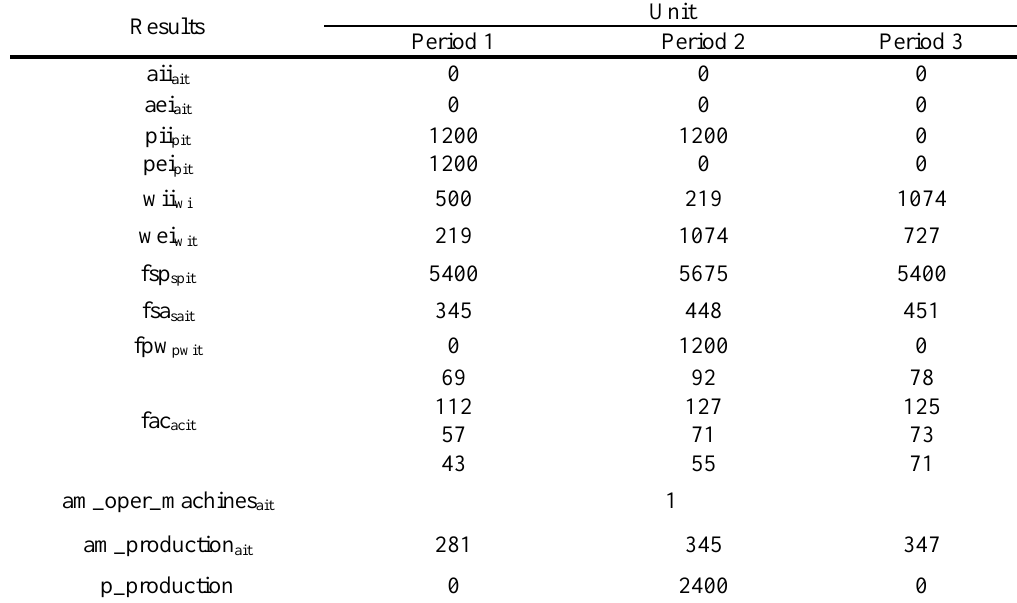
Table 2. Solution of integer decision